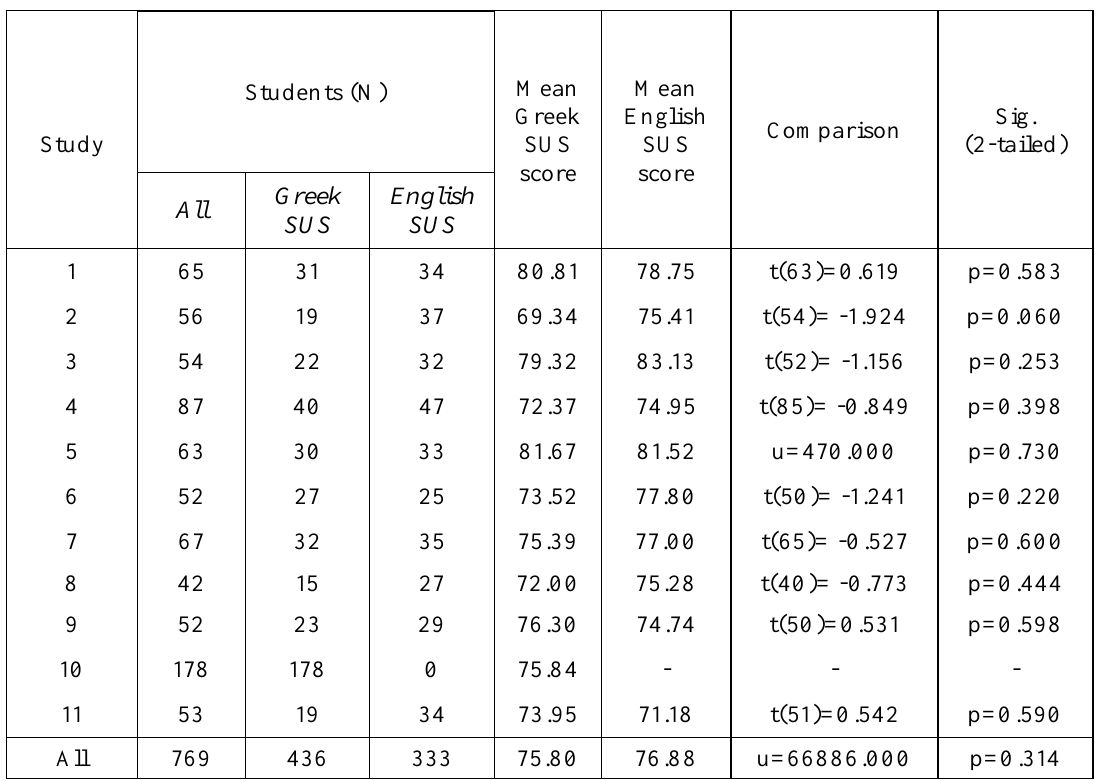
Validity Analysis of the Greek SUS